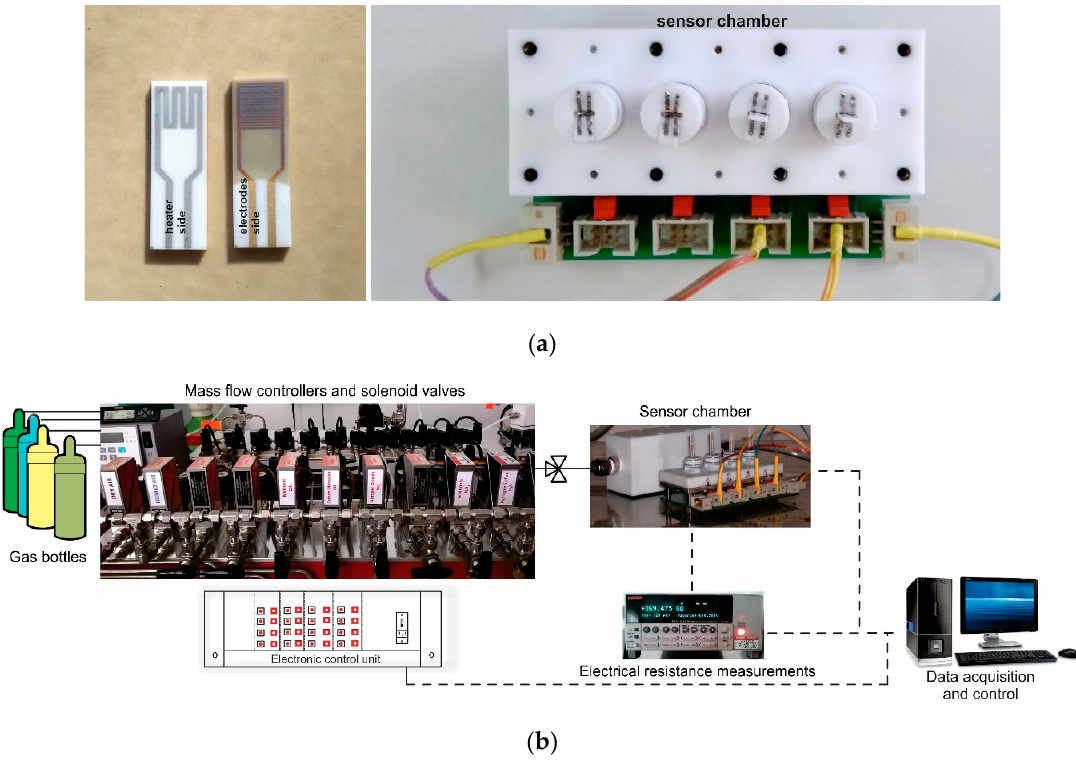
Figure 2. ( a ) Details about electrical connections of the sensor chamber and sensor layout; ( b ) Gas mixing system workbench with data acquisition.